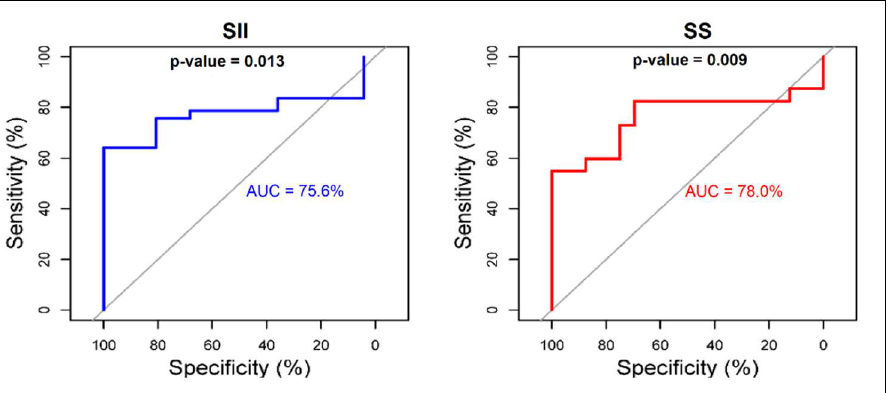
Figure 2. ROC plot for the accuracy of SS and SII in predicting sepsis using admission features in patients with odontogenic infections.